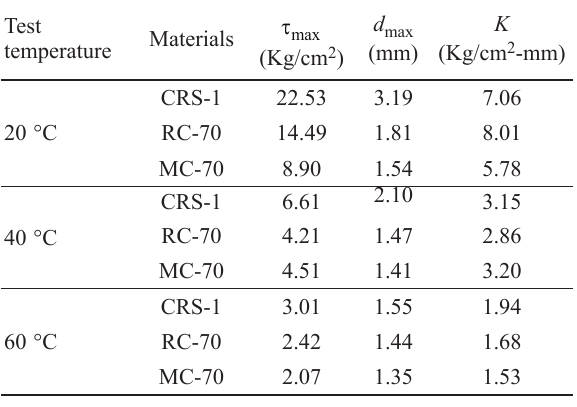
5. Interface reaction modulus and shear displacement